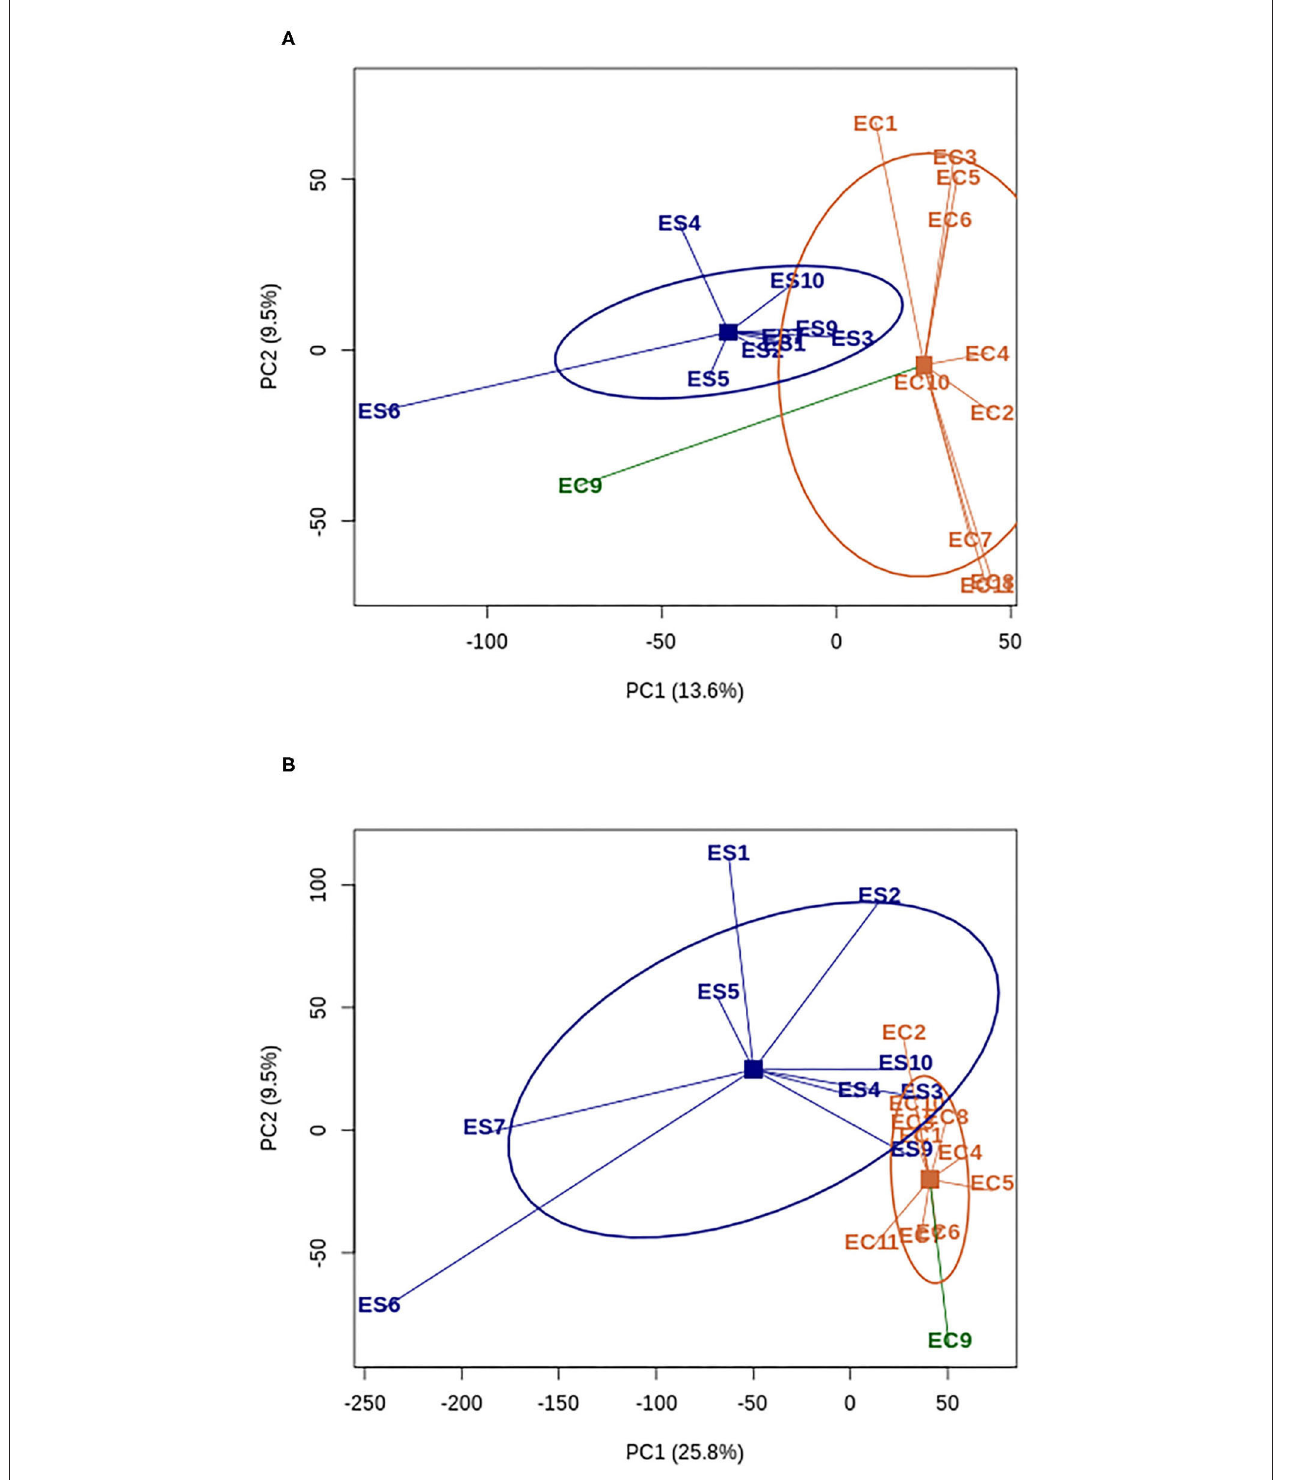
FIGURE 1 | Principal Component analysis of polymorphism (A) and expression data (B) for wild (blue) and domesticated (orange) accessions of Sorghum bicolor . The accession EC9 corresponding to domesticated race guinea margaritiferum is represented with a different color (dark green) since its diversity patterns stand out from the domesticated pool. ES: wild; EC: domesticate. Squares represent the centroids of each group of accessions and ellipses represent the 60% 2D confidence interval.